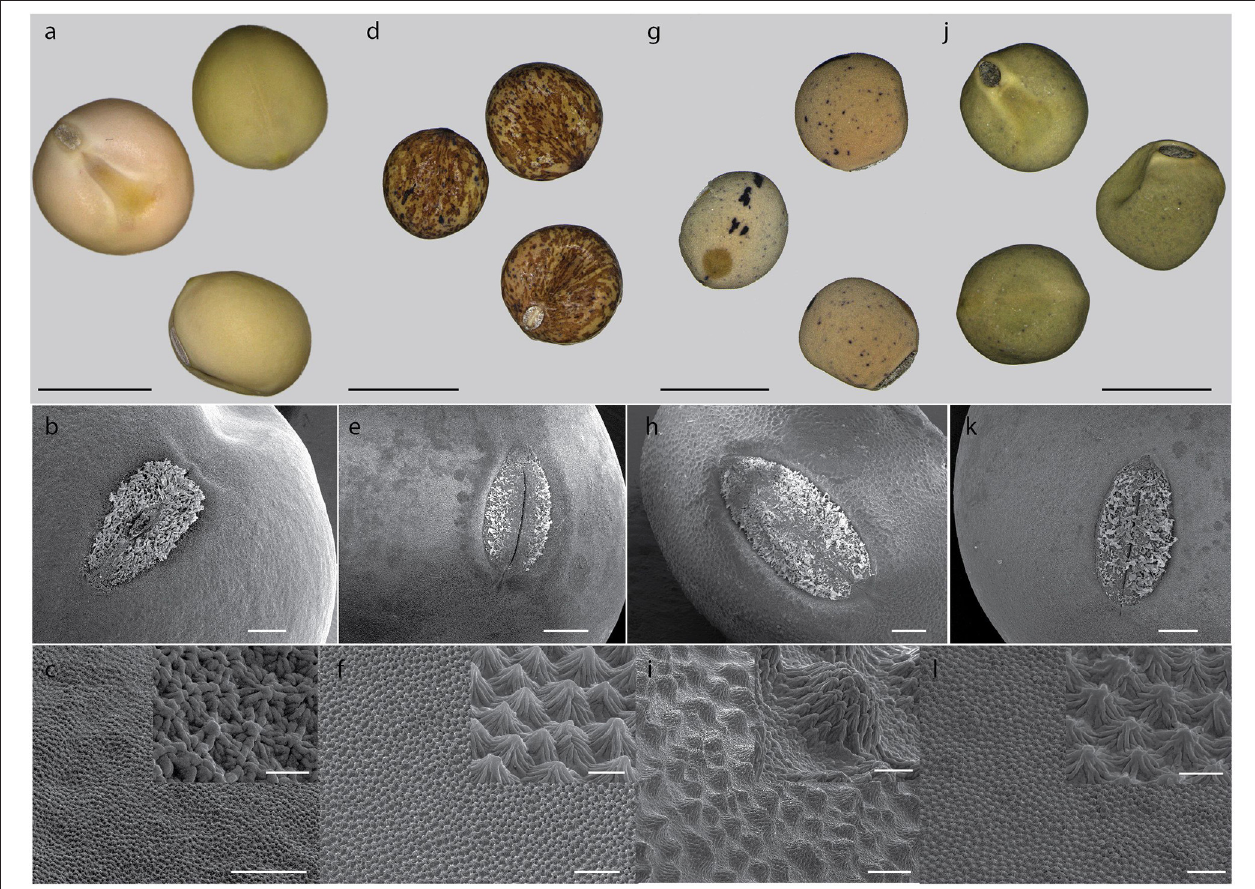
FIGURE 3 | Seed coat surface of selected pea genotypes. Pigmentation of seed coat: Cameor (a) , JI92 (d) , JI64 (g) , and VIR320 (j) ; scale bar = 5 mm. Surface texture (SEM): Cameor (b,c) , JI92 (e,f) , JI64 (h,i) , and VIR320 (k,l) overall view, scale bar = 500 µ m; details of extrahilar region (c,f,i,l) with inlay of high magnification, scale bars = 100 µ m (c,i) and 50 µ m (k,l) , inlay scale bars = 10 µ m (c) 20 µ m (l)